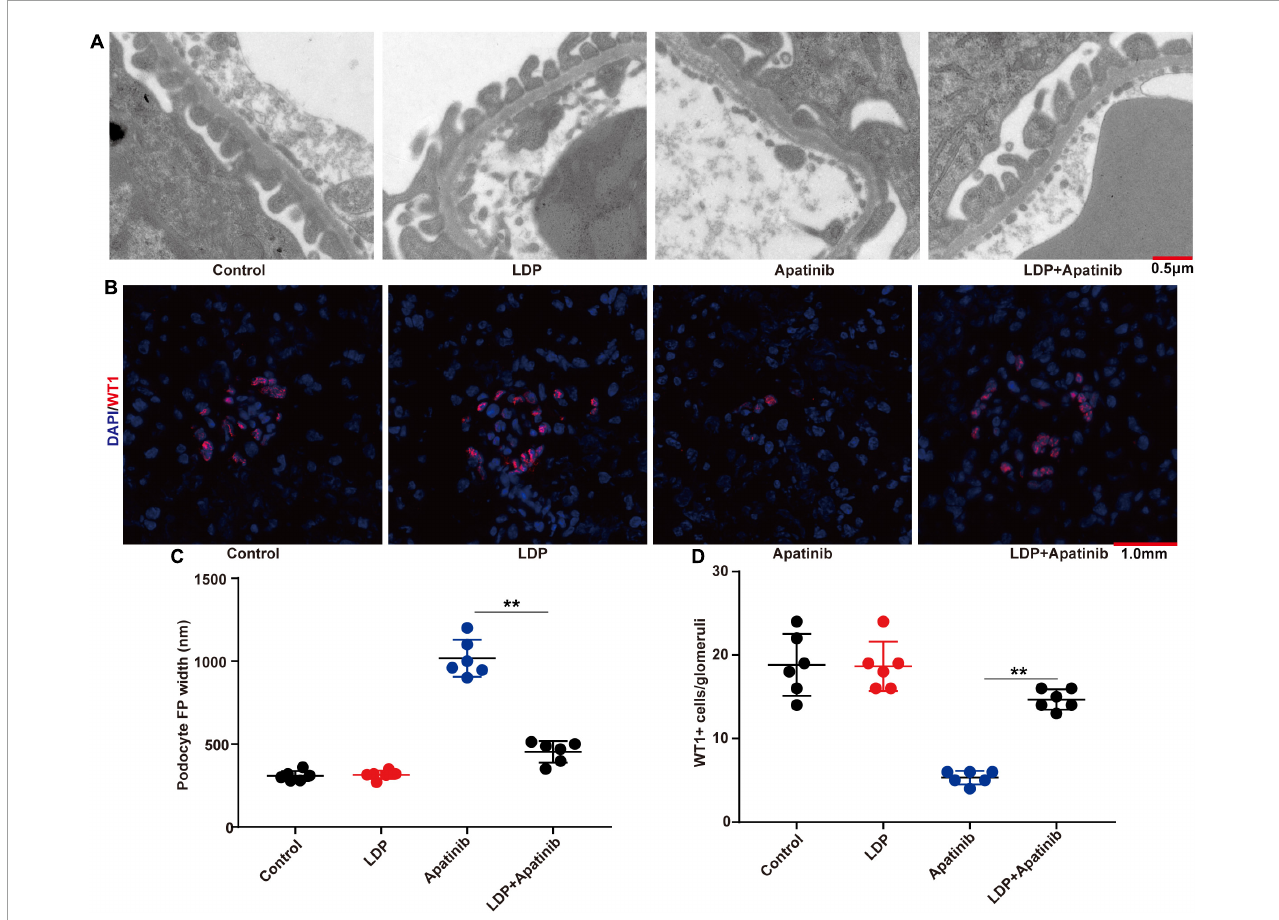
FIGURE5 LDP alleviates podocyte loss and foot process effacement in BALB/c nude mice. (A) Representative glomerular filtration barrier of mice treated with LDP, apatinib and LDP + apatinib under a transmission electron microscope ( n = 6 in each group). (B) Representative glomerular WT-1 staining of BALB/c nude mice which were treated with LDP alone, Apatinib alone, or both. 12 fields were selected randomly for WT-1 + staining quantification ( n = 6 in each group). (C) The distribution width of podocytes in each group. (D) WT-1 expression in each group, ** p <